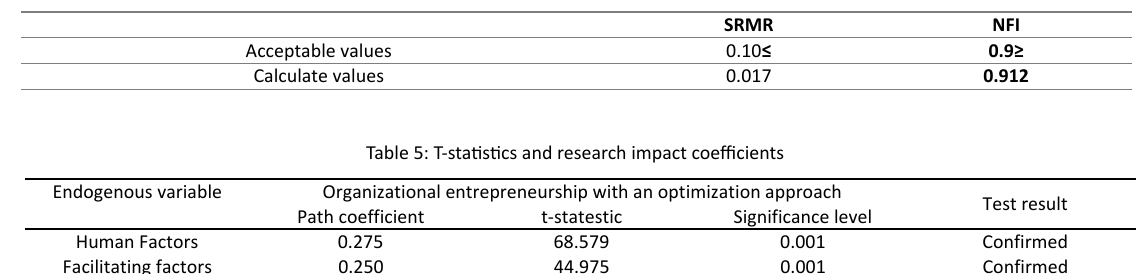
Table 4 . Fitness indexes (Source: Authors’ elaboration) Table 4. Fitness indexes (Source: Authors’ elaboration)